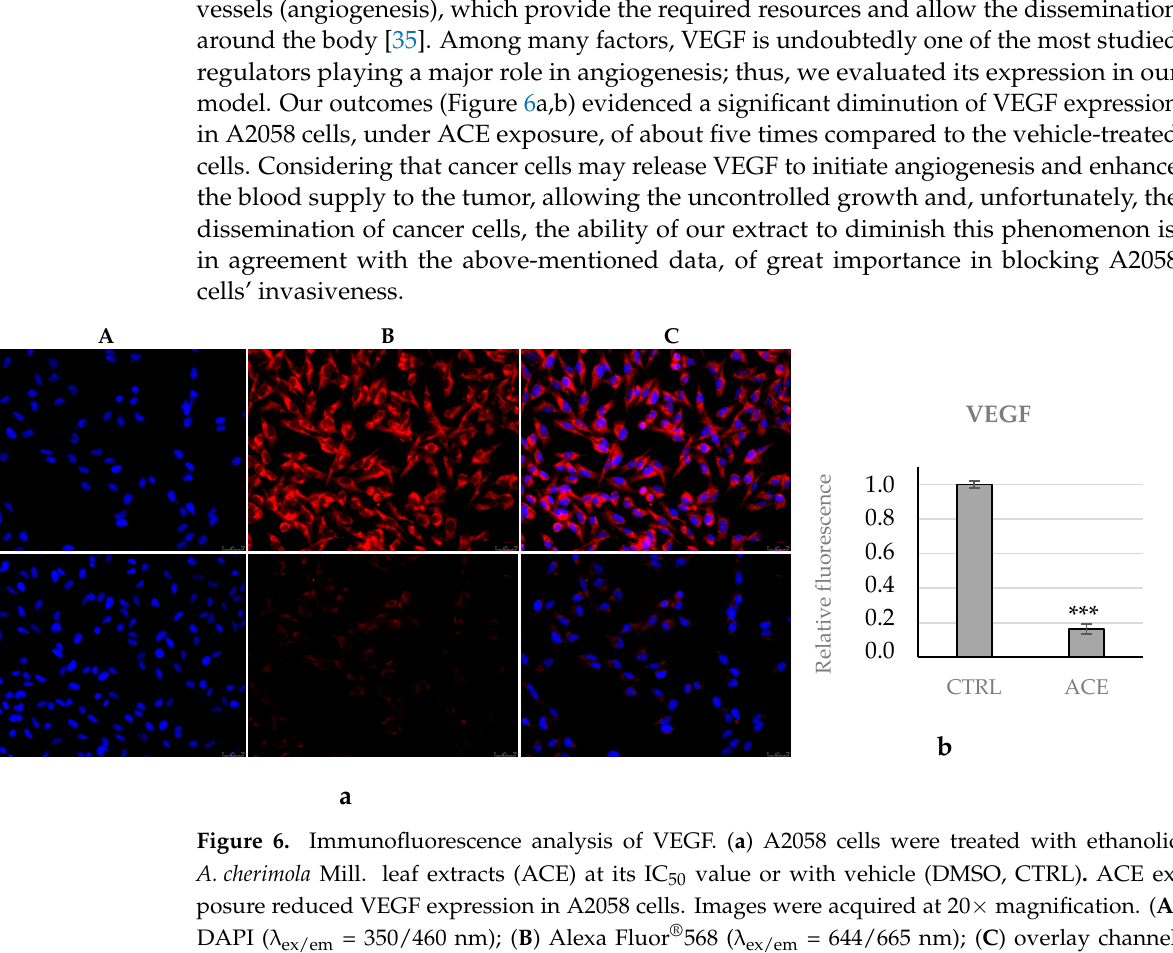
tine, white arrows). Moreover, the presence of some bi- or tri-nucleated cells suggest an 606